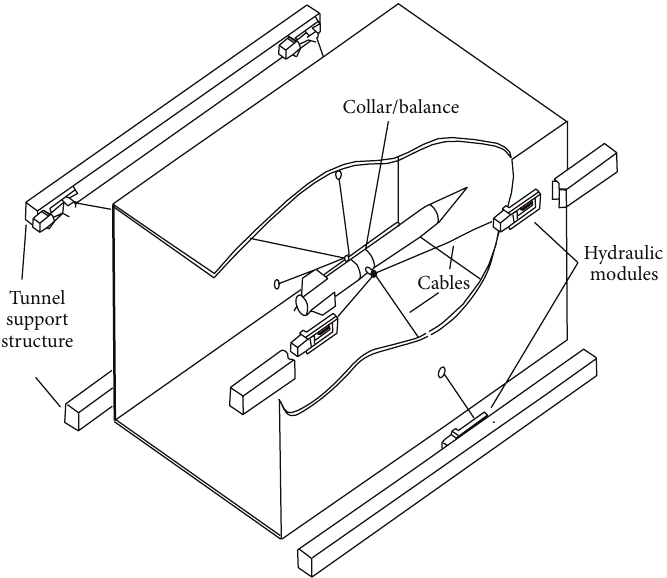
Figure 15: Hydraulic modules for actuating the missile model to yaw [93].